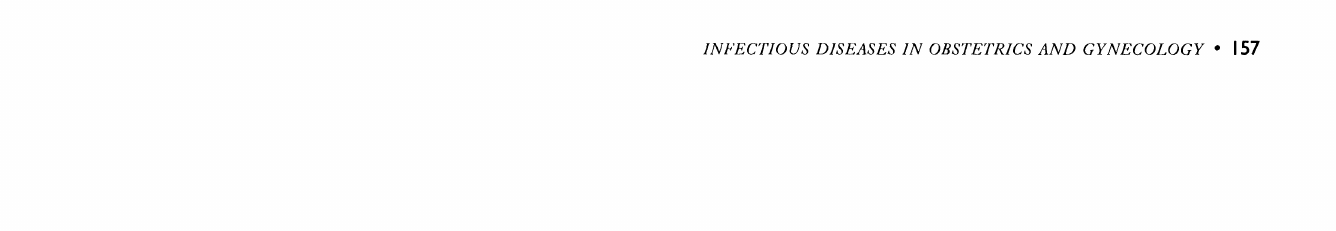
TABLE 3. Morbidity associated with diarrhea